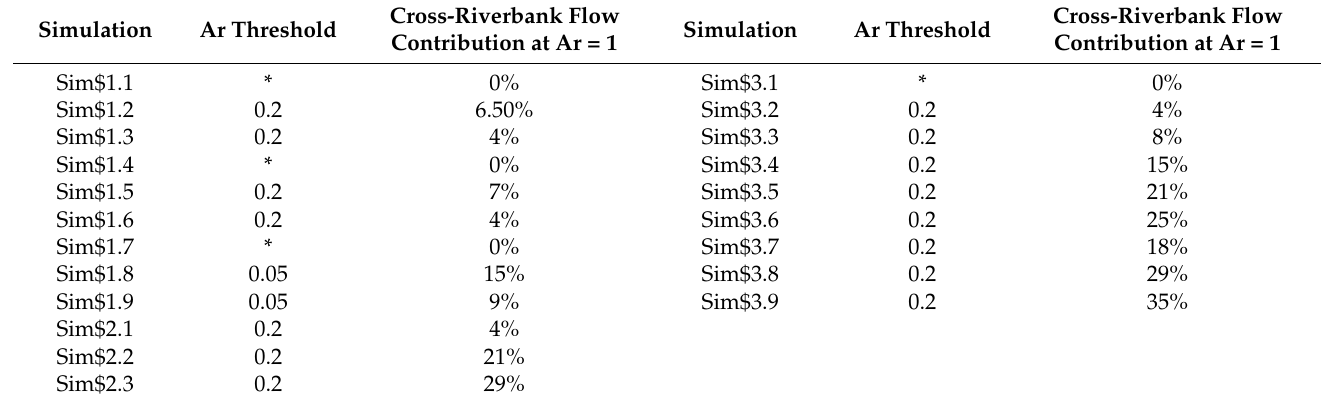
Table 5. Simulation results: the Ar threshold is the minimum aspect ratio value to obtain a contribu- tion of the regional left GW flow, the cross-riverbank flow contribution at Ar = 1 is the contribution of the regional left GW flow at Ar = 1 and * refers to the flow conditions not allowing a cross- riverbank